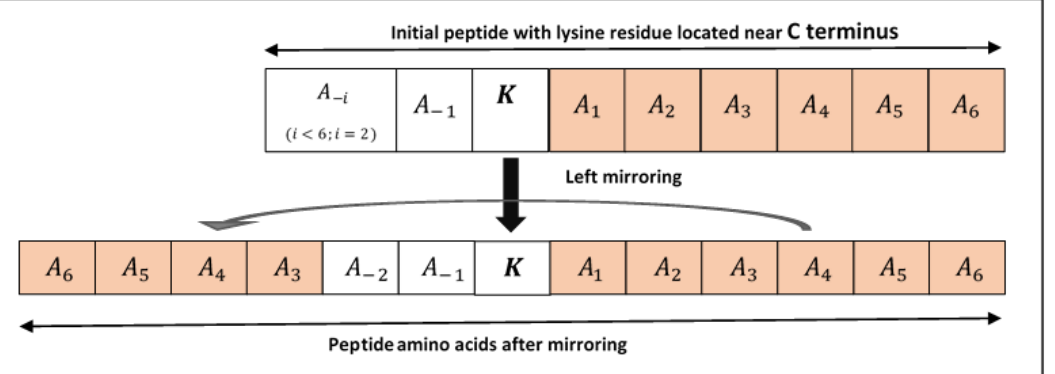
Figure 2. Shows arrangement of lysine residue’s neighboring amino acids with ample upstream and downstream amino acids.